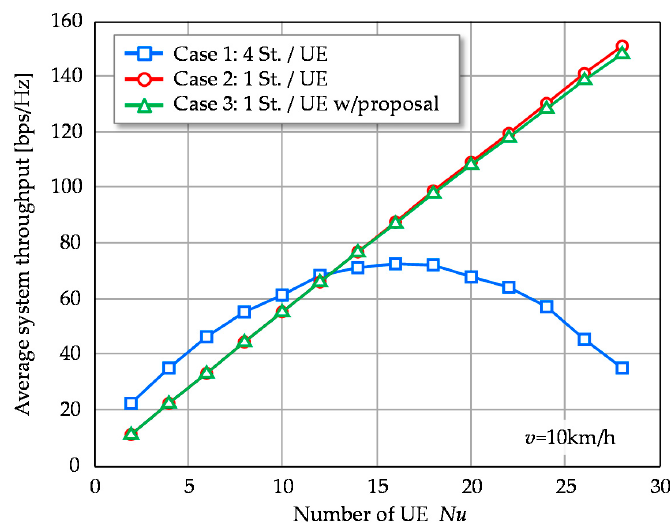
Figure 10. Average system throughput versus number of multiplexed UEs.